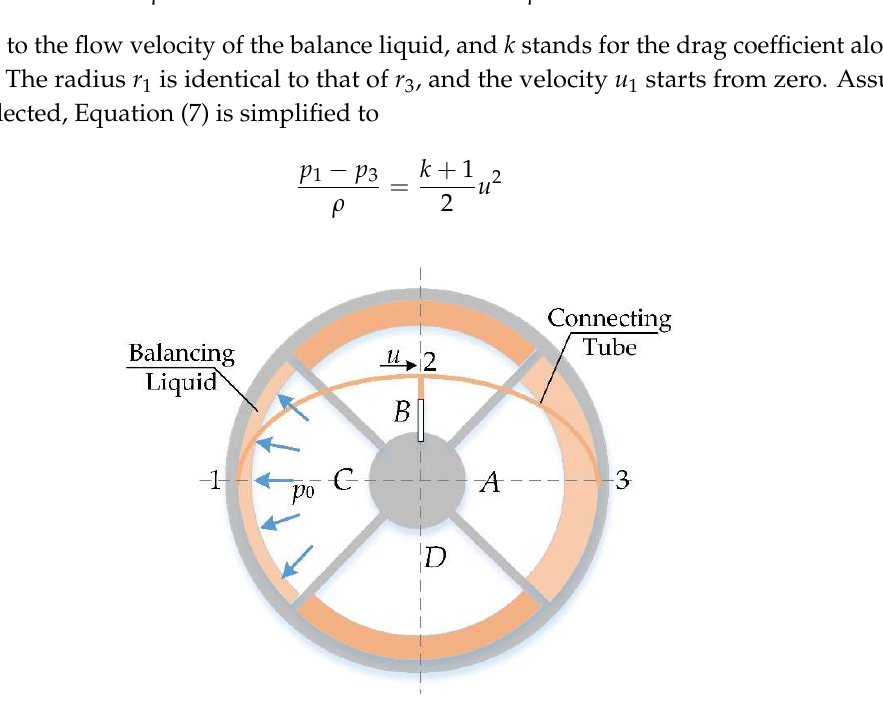
Figure 4. Flow procedure of the balance liquid.